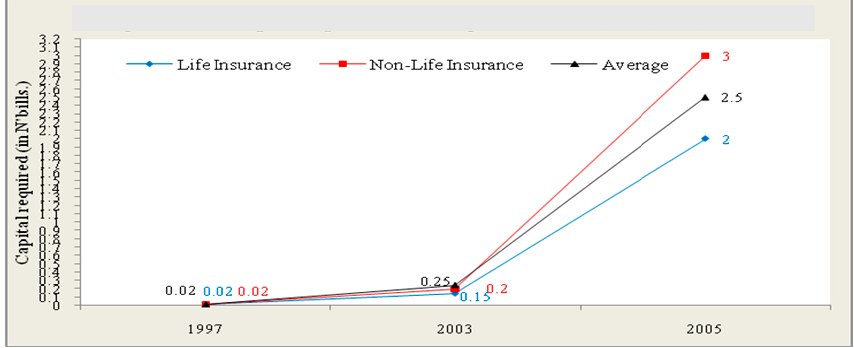
Figure 3. Trend of capital requirement for Nigerian Insurers, 1997, 2003, 2005. Source: NAICOM, 2015.